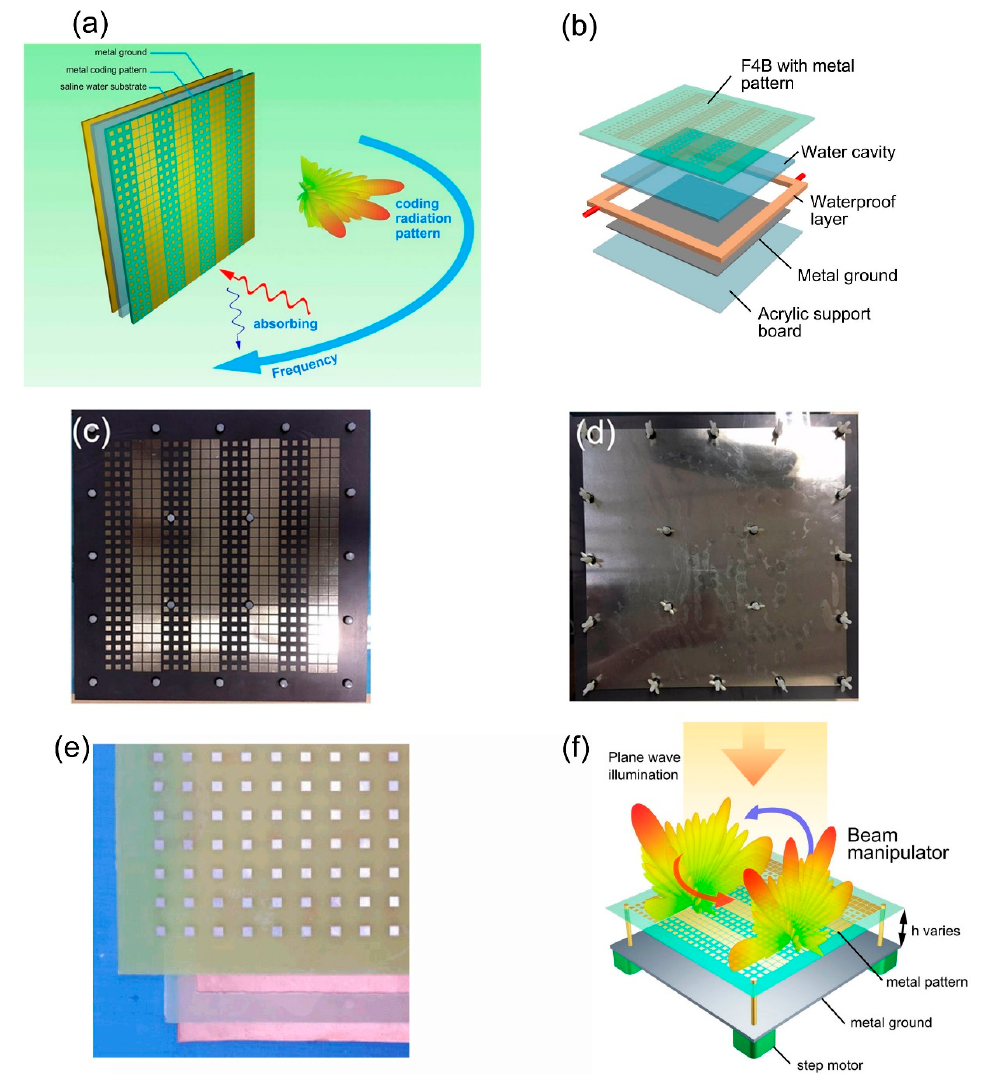
Figure 1. ( a ) The schematic of tunable metasurface based on saline water substrate (from Figure 1 of Ref. [104]). ( b ) The detailed structure of the fabricated sample (from Figure 8a of Ref. [104]). ( c , d ) The top and bottom views of the fabricated sample (from Figure 8c,d of Ref. [104]). ( e ) The schematic of preassembled tunable metasurface absorber based on temper- ature control (from Figure 4a of Ref. [105]) ( f ) Schematic diagram of reconfigurable metasurface based on mechanical control (from Figure 1 of Ref. [106]). Reproduced with permission from Ref. [104] under a Creative Commons Attribution 4.0 International License. Reproduced with permission from Ref. [105] provided by AIP Publishing and Copyright